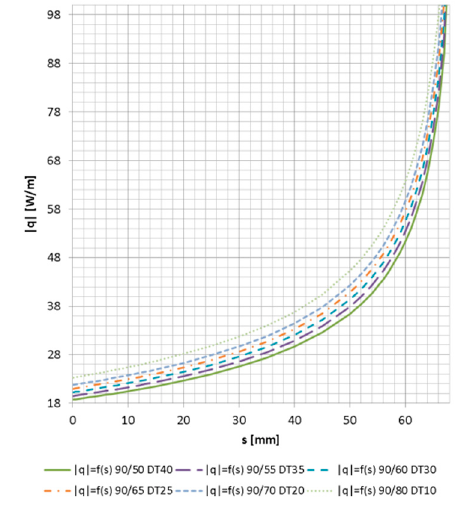
Figure 3. Heat losses through the supply and return pipes as a function of the distance between these pipes at different return temperatures (q = f(s, T R )).